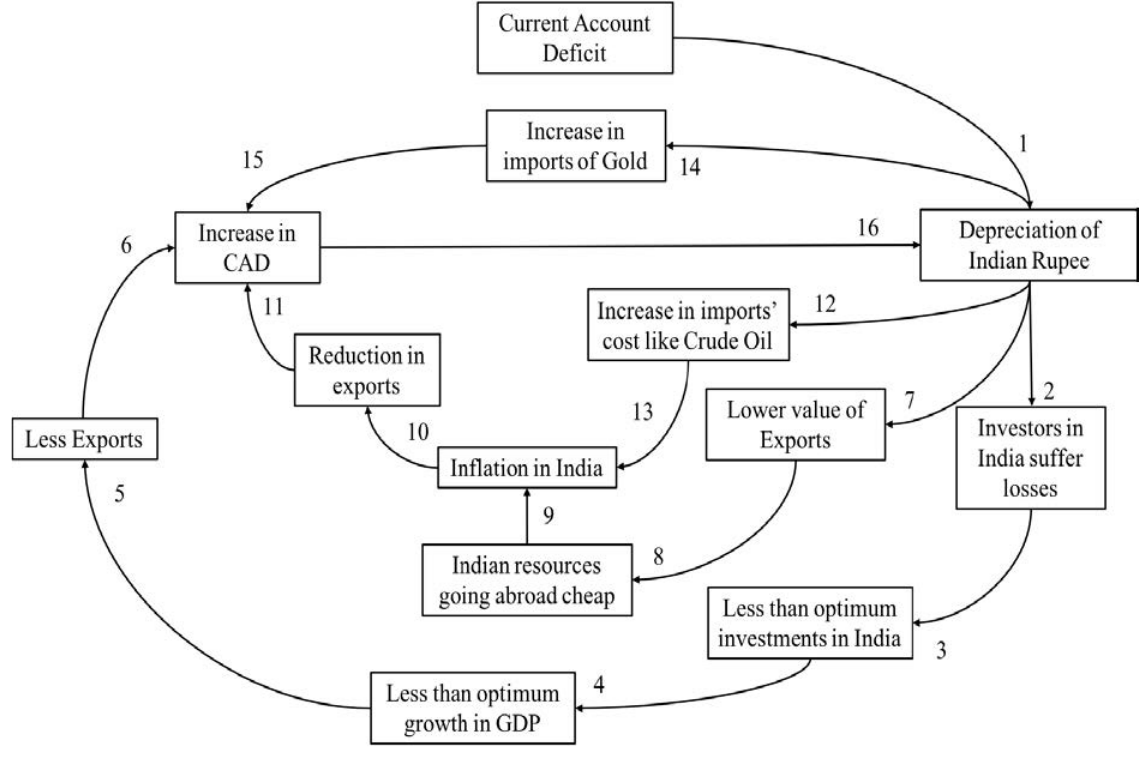
Figure 2. Transmission channel of fiscal deficit and inflation.